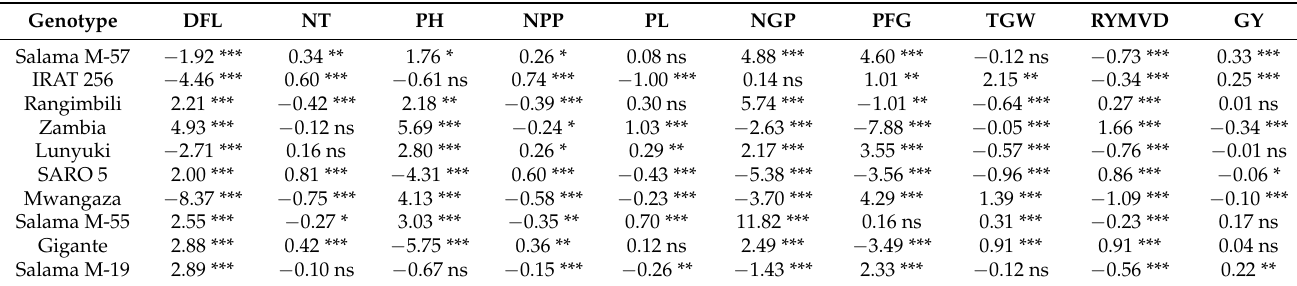
Note: DF = degree of freedom; DFL = Days to 50% flowering; NT = number of tillers/plant; PH = plant height; NPP = number of panicle/panicle; PL= panicle length; NGP = number of grains/panicle; PFG = percentage filled grains/panicle; TGW = thousand grain weight; RYMVD = rice yellow mottle virus disease; GY = grain yield; * = p < 0.05; ** = p < 0.01; *** = p < 0.001; ns,